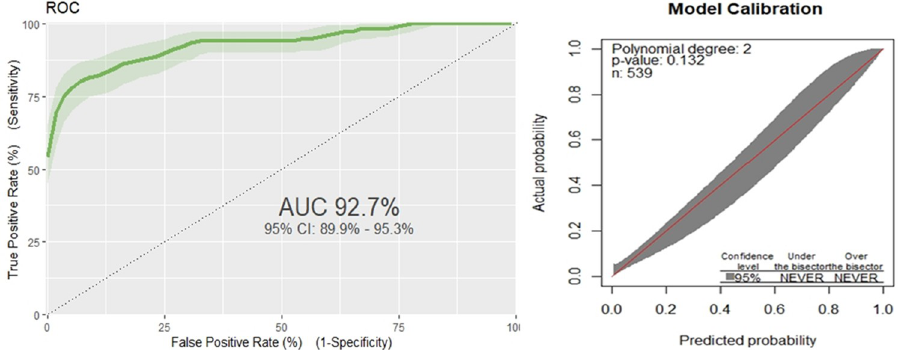
Fig 1. Receiver operating characteristics curve for prediction model of the original model (a), Calibration belt for the original model: predicted probability versus observed probability poor outcomes of SCAP in under-five children (b).